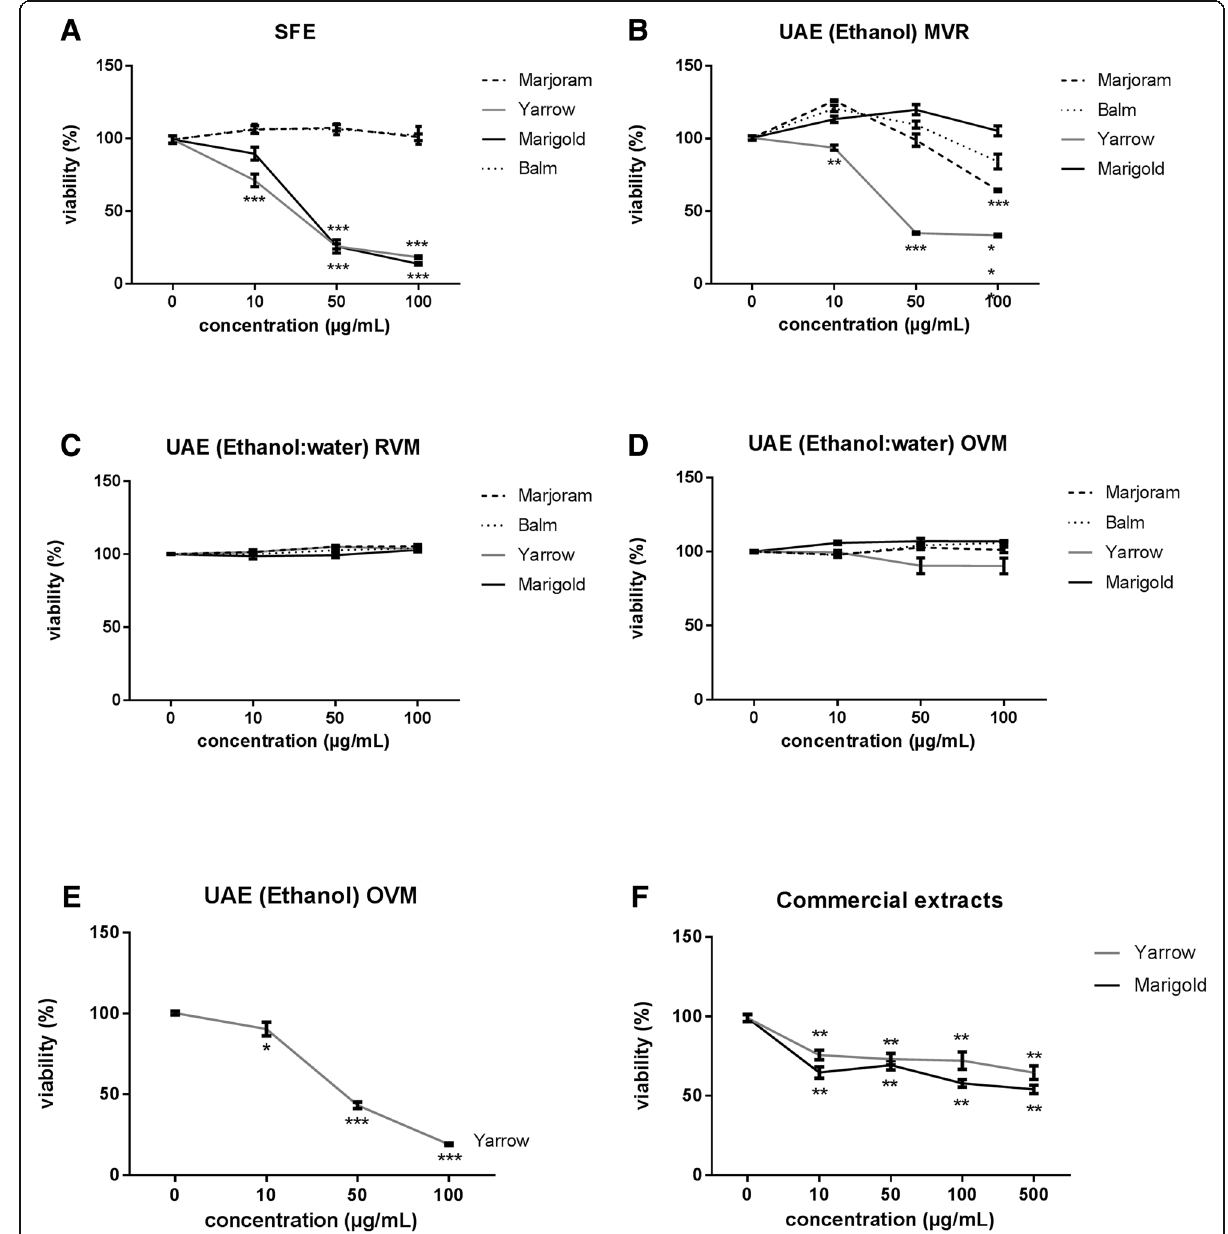
Fig. 2 Dose-response curves of cell viability assays after 48 h treatment of MIA PaCa-2 human pancreatic cancer cells with increasing concentrations of SFE extracts ( a ), UAE (Ethanol) MVR extracts ( b ), UAE (Ethanol:Water) MVR extracts ( c ), UAE (Ethanol:Water) MVO extracts ( d ), UAE (Ethanol) MVO extracts ( e ) and commercial extracts ( f ). Data represent means ± S.E.M of at least three independent experiments each performed in quadruplicate. Asterisks indicate statistical differences in treated cells with respect to the control (non-treated cells, DMSO 0.1%). * p <0.05; ** p <0.01; *** p